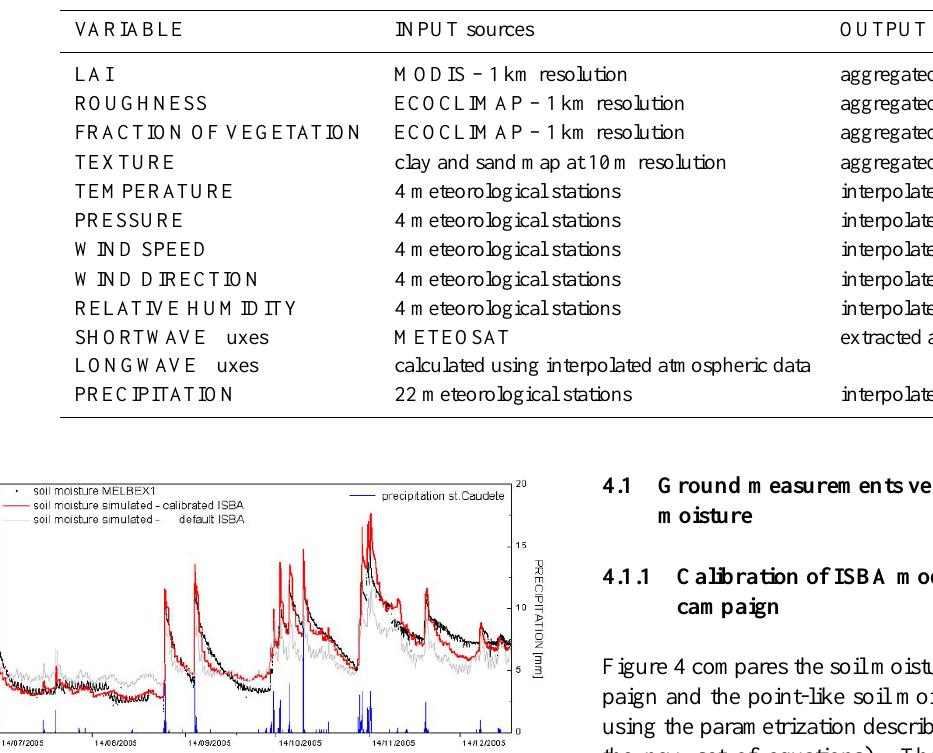
Table 3. Resolution and data used as input of the SVAT model in order to obtain the spatialized soil moisture.